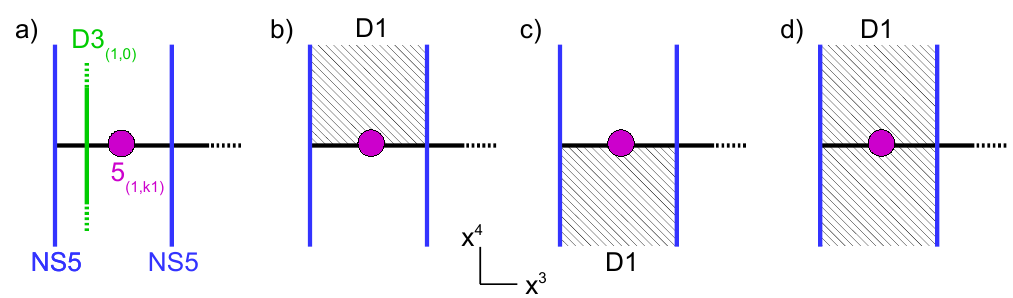
Figure 26 . Setups realizing the insertion of the branch I operators: (a) X I , (b) v + setup revealing the relation v +